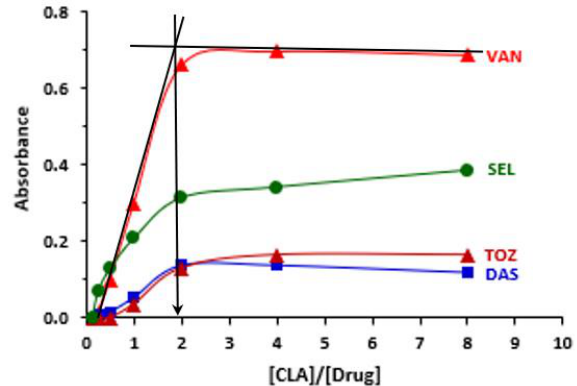
Figure 5. Plot of absorbance versus molar ratio of [CLA]/[Drug] obtained from reaction mixtures containing a fixed concentration of drug and varying concentrations of CLA. The mole ratio corre- sponds to the point of intersection of the tangents of straight-line portions of the plots (as shown for VAN). Measurements were carried out at 490 nm.